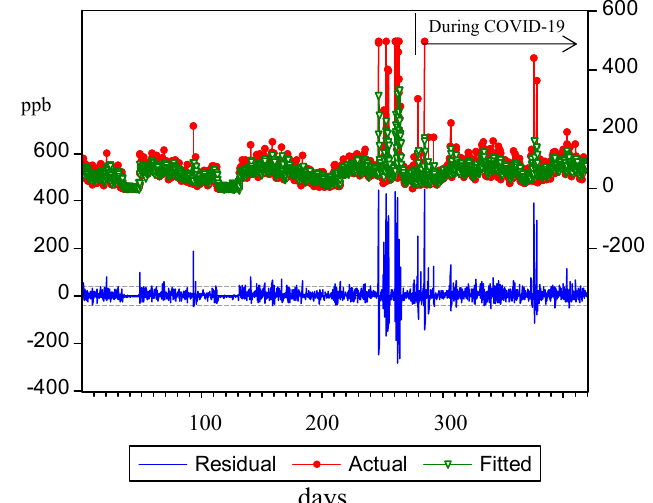
Figure 3. Estimation of the concentration of O 3 with the VARMA (1,1)-EGARCH (1,1) model.